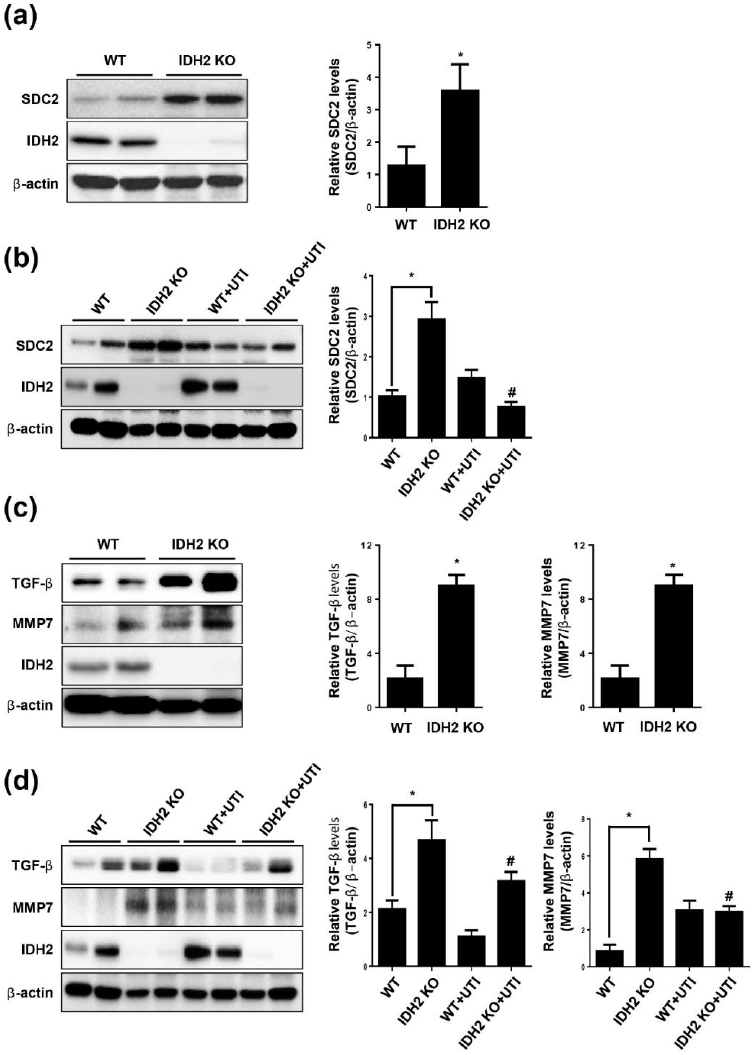
Figure 4. Effect of UTI on SDC2, MMP7 and TGF- β signaling in aorta from IDH2 KO mice. Aorta were isolated from WT and IDH2 KO mice and after peritoneal injection of UTI in WT and IDH2 KO mice. ( a , b ) Protein level of SDC2, ( c , d ) TGF- β and MMP7 were detected by western blotting. β -actin was used as a loading control. Protein levels were quantified by densitometric analysis using Image-J software (Shown in the right panel). All data are presented as means ± SEM, * p < 0.05 compared with WT mice, # p < 0.05 compared with UTI injected IDH2 KO mice (n = 10 mice/group).